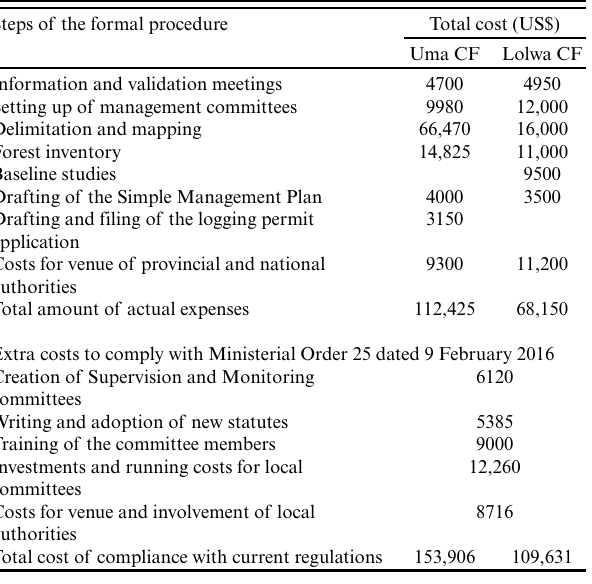
Table 1 . Cost of creating the local community forest (CF) concession at the two pilot sites.